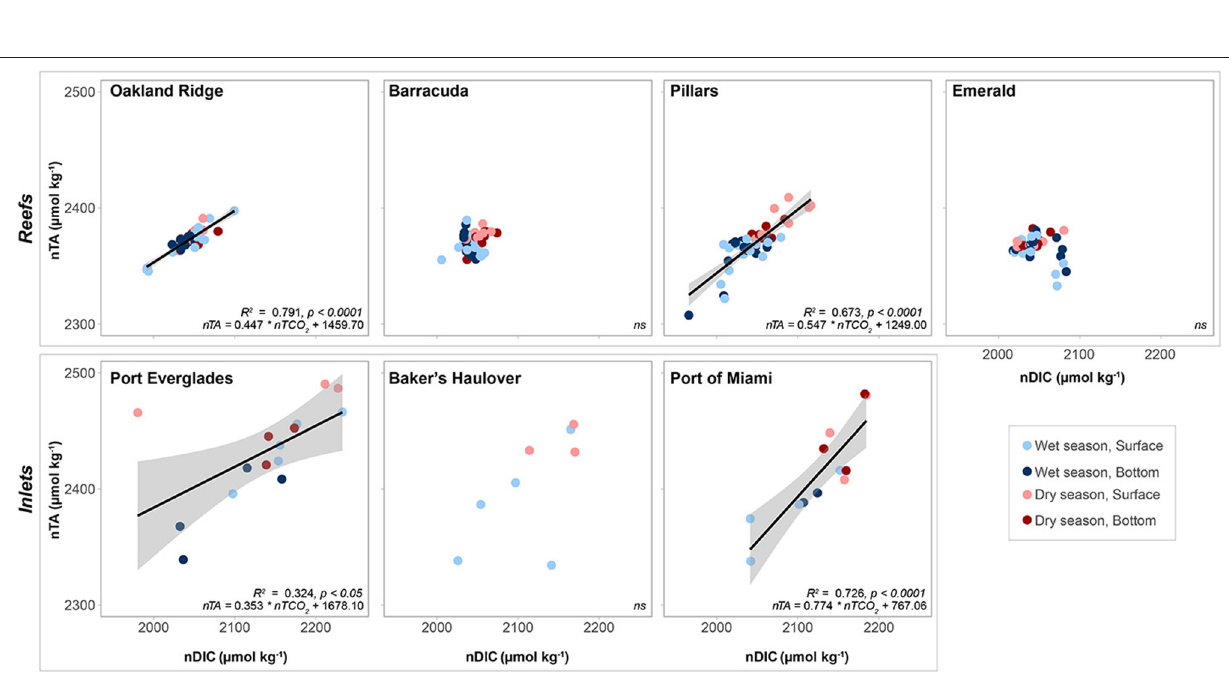
Frontiers in Marine Science |